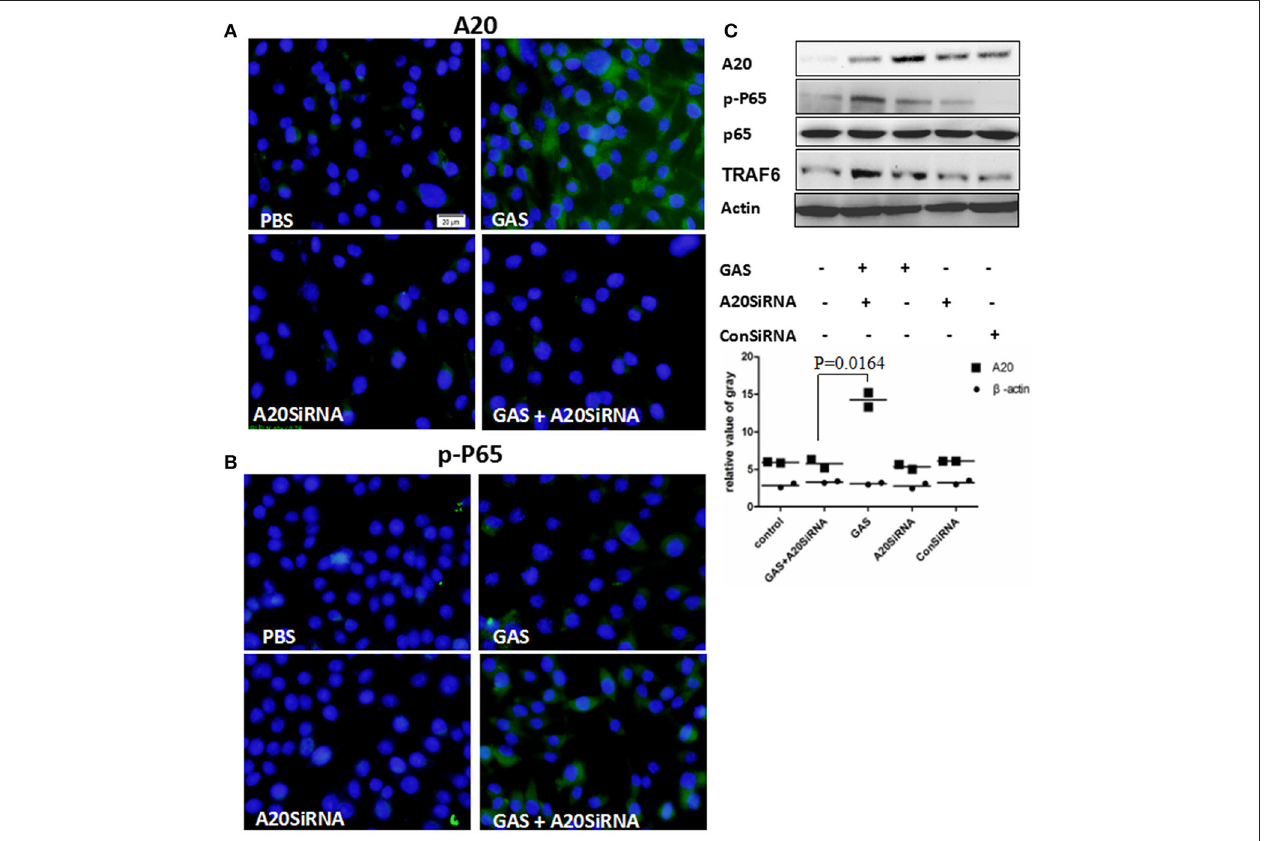
FIGURE 4 | Expression of A20 and the phosphorylation of p65 in RAW 264.7 macrophages with and without A20 SiRNA following GAS infection. RAW 264.7 cells were incubated with A20 SiRNA for 30min, and then infected with GAS at an MOI of 10: 1. Six hours post-infection, an immunofluorescence assay (magnification, 3100) was performed to detect the expression of A20 (Green) (A) and p-P65 (Green) (B) , which was verified by Western blotting (C) . qPCR (for mRNA expression) or ELISA (for protein expression) were also used to detect the levels of proinflammatory cytokines in RAW cells or in the supernatant ( Figure 5 ). The blue color represents DAPI staining. Representative cells from the same field for each group are shown. Each experiment was repeated three times, and similar results were obtained on each occasion.